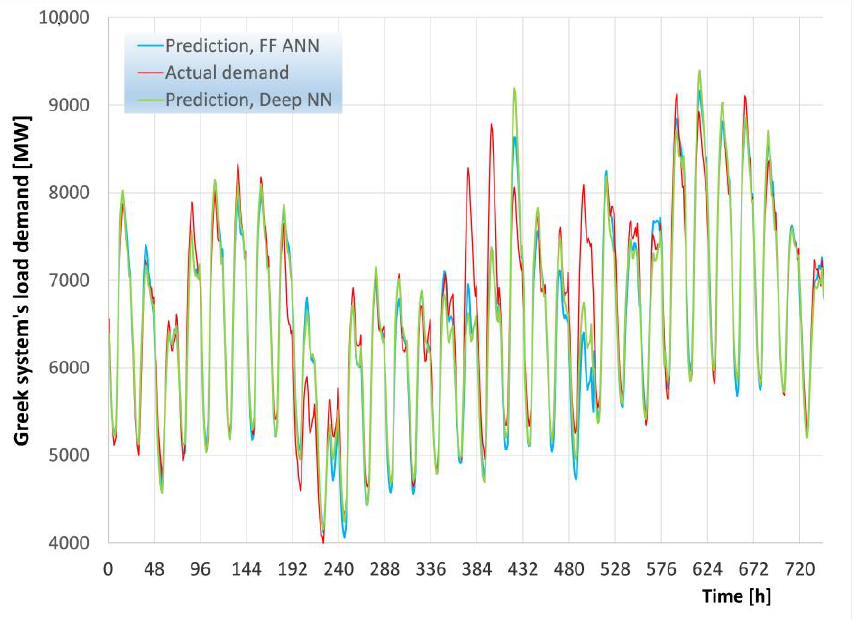
Figure 18. Prediction and validation of system’s demand for July 2022, FF-ANN after 81 epochs vs. Deep NN after 1000 epochs.